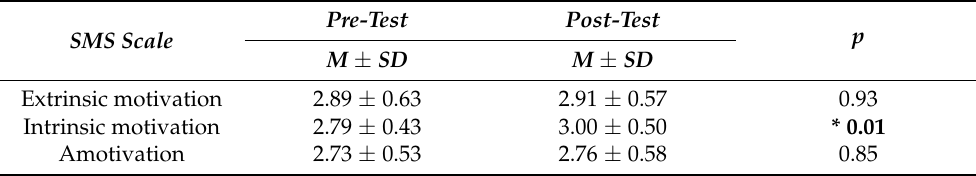
Table 6. The results of the SMS questionnaire in Test group 1. SMS Scale